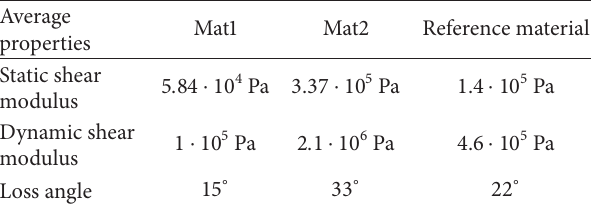
Table 1: Material properties of Mat1, Mat2, and reference material.